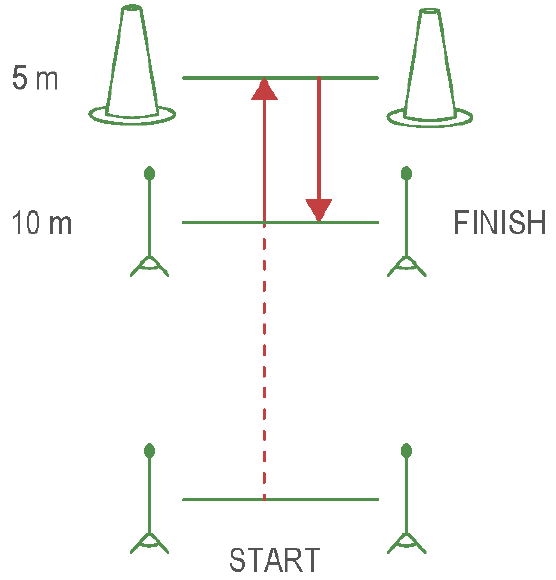
Figure 10. Modified 505 Test. A single COD sprinting test, as previously described by Stojanović et al. [18] from which the picture was adapted and edited.